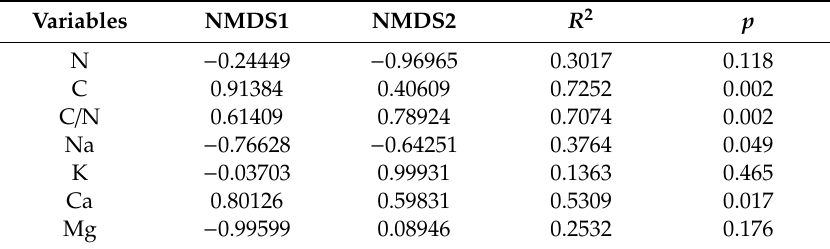
Table 1. Goodness-of-fit statistics ( R 2 ) for factors fitted to the non-metric multidimensional scaling (NMDS) ordination of fungal community composition of indicated plant